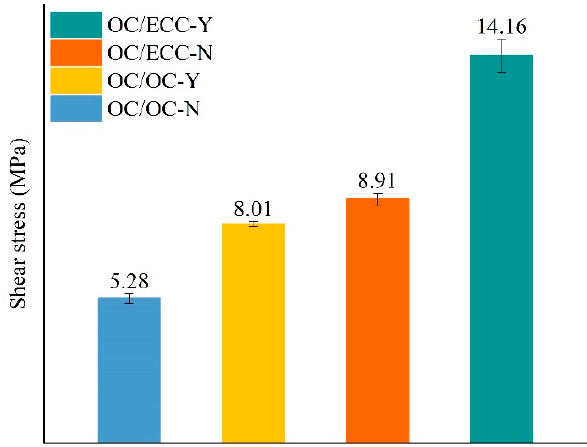
Figure 9. Shear stress of each group.